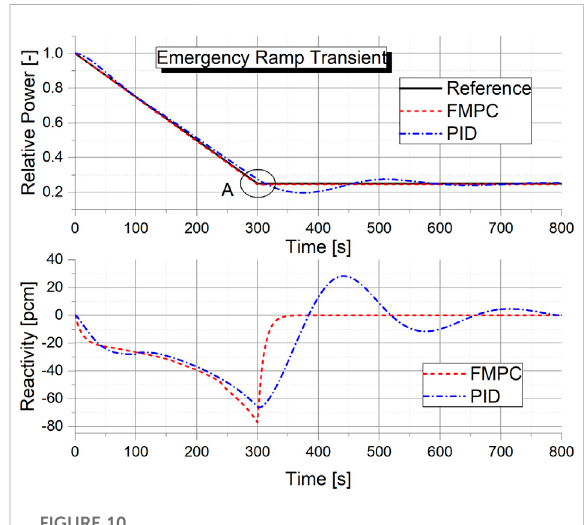
EnlargedviewoftheareaAfortheemergencyramptransient.